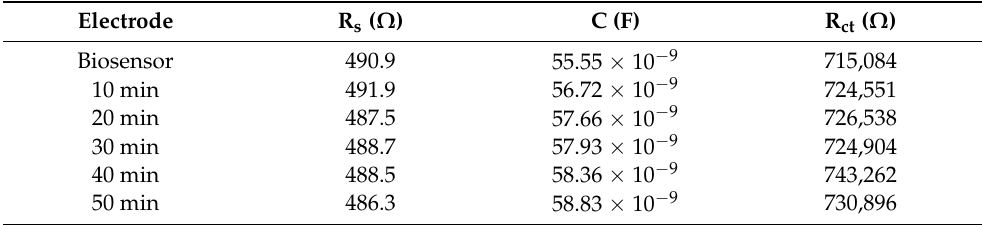
Figure 5. EIS results of the biosensor anti-a β /SAM/ICE with the treatment in EPPS at different time intervals display in ( a ) Nyquist plots and ( b ) Normalization of R ct . (n = 3; three data points shown). Table 2. EIS parameters of the anti-a β /SAM/ICE biosensor after treatment with EPPS at different time intervals, extrapolated by fitting the measured spectra in Figure 5a to the equivalent circuit model of Randle.